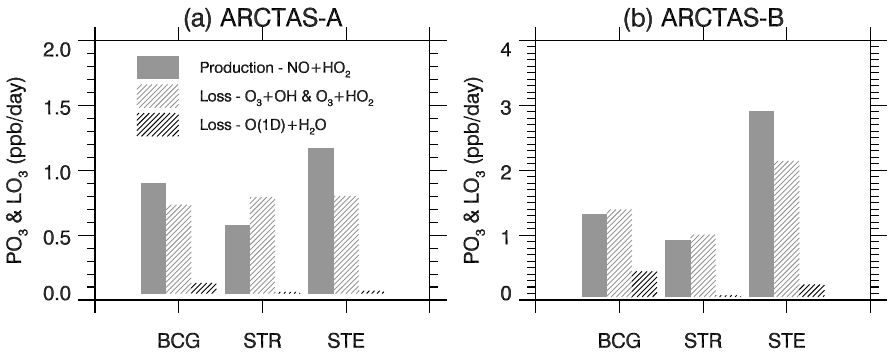
Fig. 12. The mean instantaneous rates of K 2 [HO 2 ][NO], K 6 [H 2 O][O( 1 D)] and K 7 [HO 2 ][O 3 ] + K 8 [OH][O 3 ] within the three types of air masses sampled between 6–12km during ARCTAS: background (BCG), stratospheric air (STR), stratosphere-troposphere mixed air (STE). These instantaneous rates are calculated offline based on the observed O 3 , temperature, and the instantaneous OH, HO 2 , NO, O( 1 D) calculated by the NASA Langley box model.